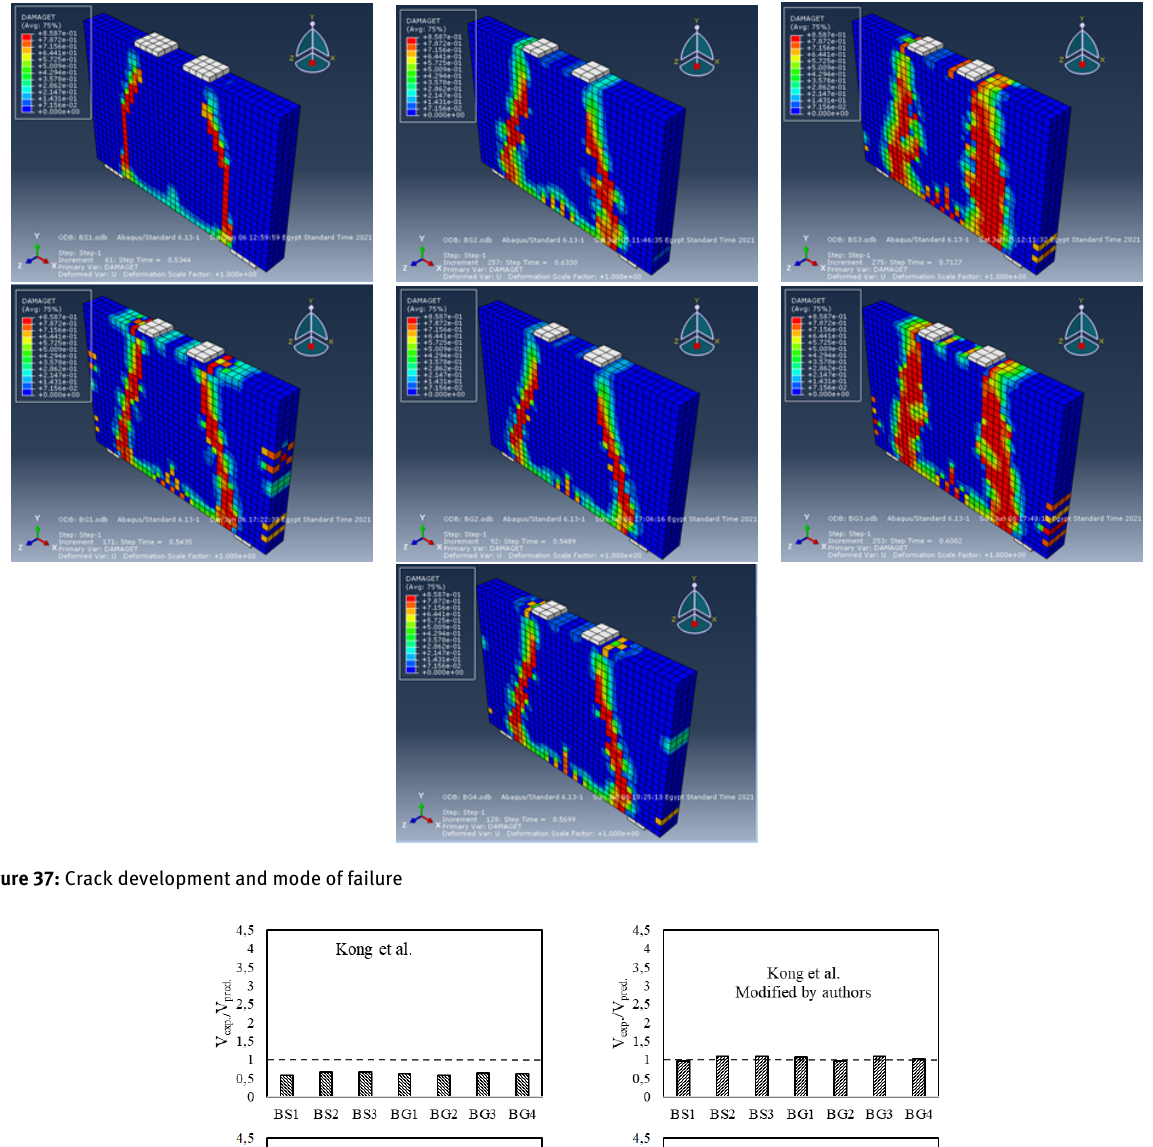
Figure 37: Crack development and mode of failure